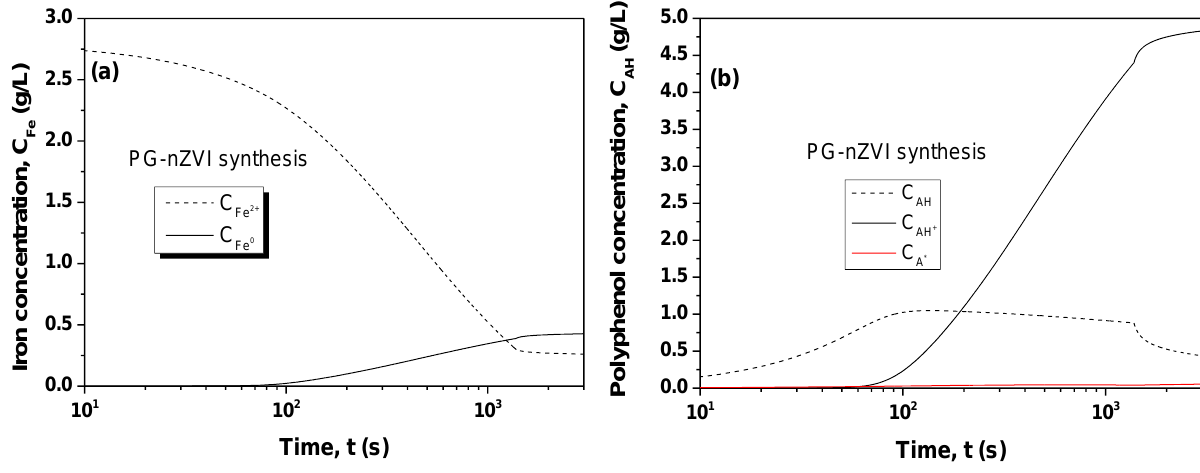
Figure 13. Numerically predicted transient responses of the concentration of (a) iron species, (b) polyphenol species, during the PG-nZVI